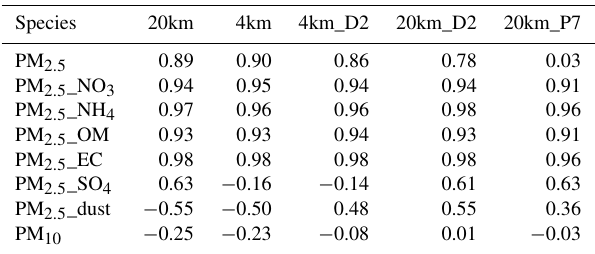
Table 2. Correlation with observations for different species at Fresno,